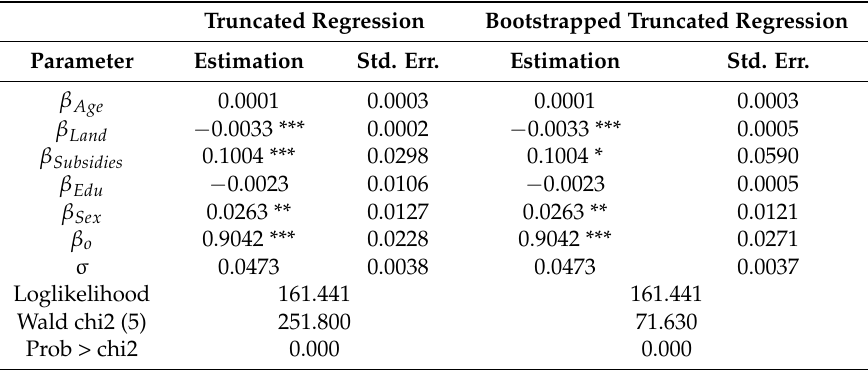
Table 5. Results of the Truncated Regression Model